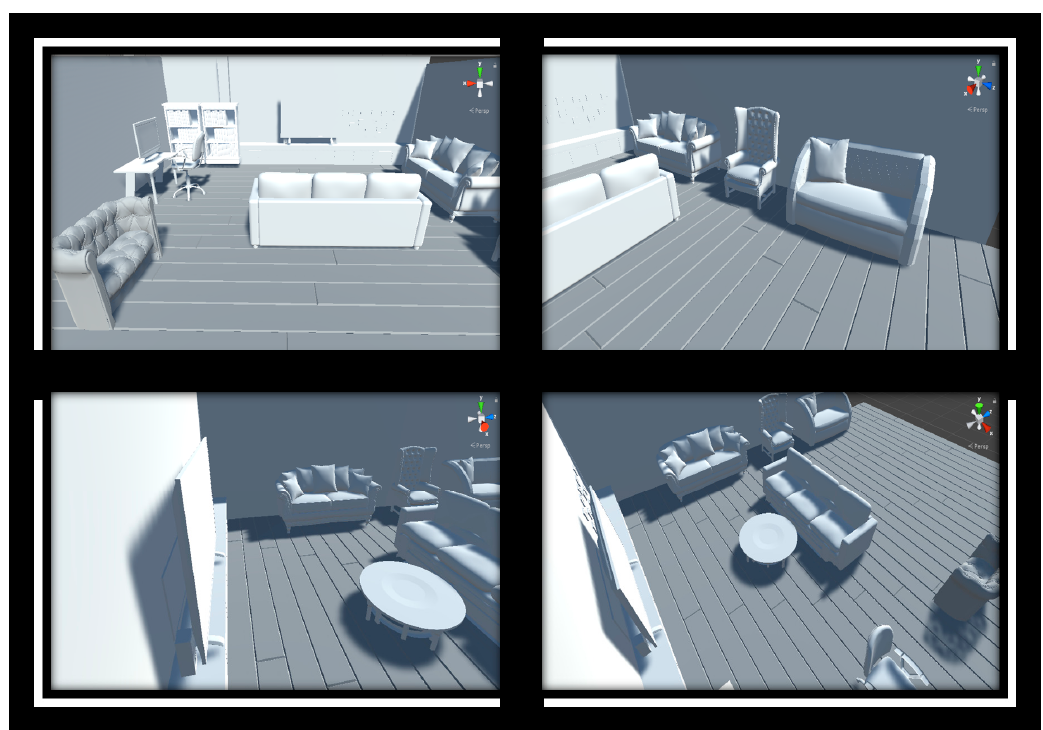
Figure 14. Virtual scene of a living room. The frames display four positions out of a total of eighteen for the virtual sensor [28]. All 3D models were obtained from Free3D [35].